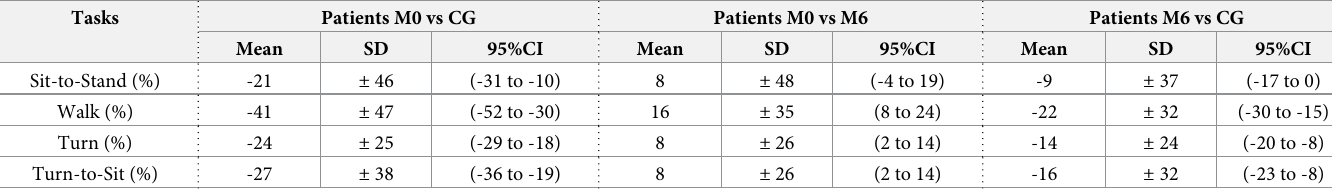
Table 5. Mean difference ± SD (95% confidence interval) between groups by phase expressed in